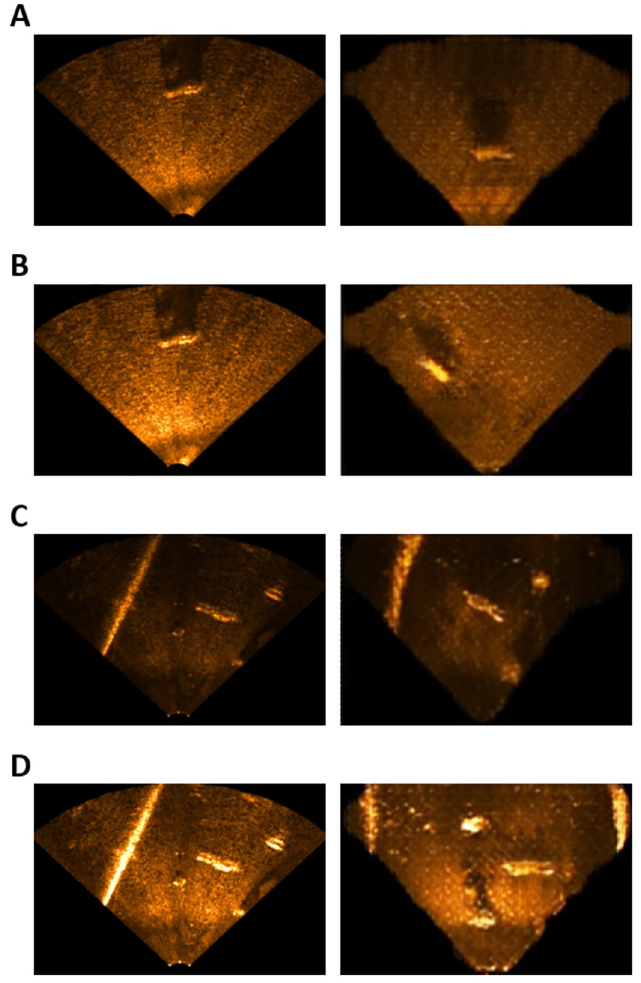
Fig 8. Results of synthetic underwater sonar image generation (left: Real underwater sonar image, right: Synthetic underwater sonar image). (A) Reservoir low sensitivity, (B) Reservoir high sensitivity, (C) Pool low sensitivity, (D) Pool high